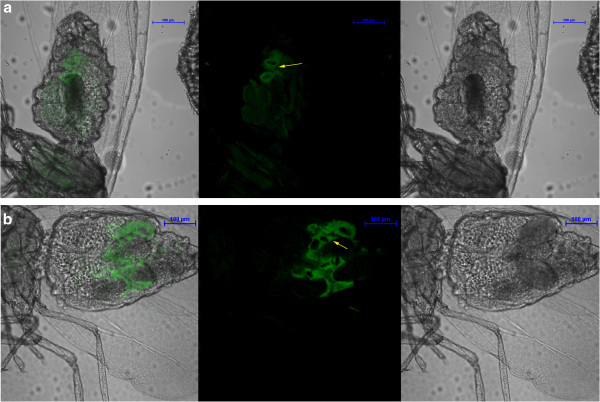
 FISH staining of Portiera 16 S rRNA in whole mount of whitefly Bemisia tabaci.  FAM labeled oligonucleotide DNA probe and modified LNA probes were used to detect Portiera in B. tabaci. (A.b) DNA probe stains for Portiera in the bacteriocytes (B.b) at the same concentration (0.6 pmoles) LNA probe shows higher signal and lower background while staining for Portiera. Arrows indicate the bacteriocytes. The images have been taken at best formamide concentration for Portiera DNA (40%) and LNA (60%) probes separately. Both DNA and LNA panels also show merged and DIC images (as a and c respectively). All the images were acquired at fixed camera and microscope settings with Nikon A1 confocal microscope.